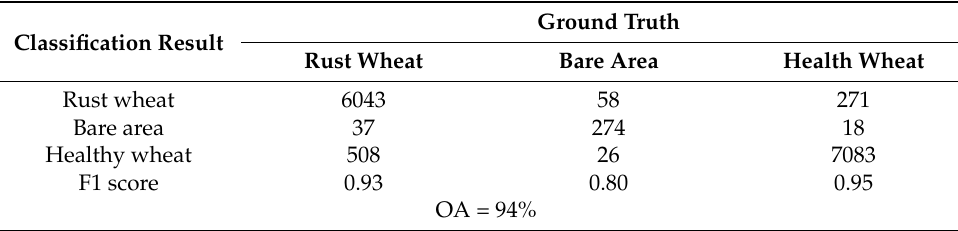
Figure 9. Confusion matrix and classification results for SVM methods and weakly supervised learning methods: ( a ) the original figure; ( b ) the SVM classification results; ( c ) the results generated by the weakly supervised learning method. Table 2. The results for weakly supervised